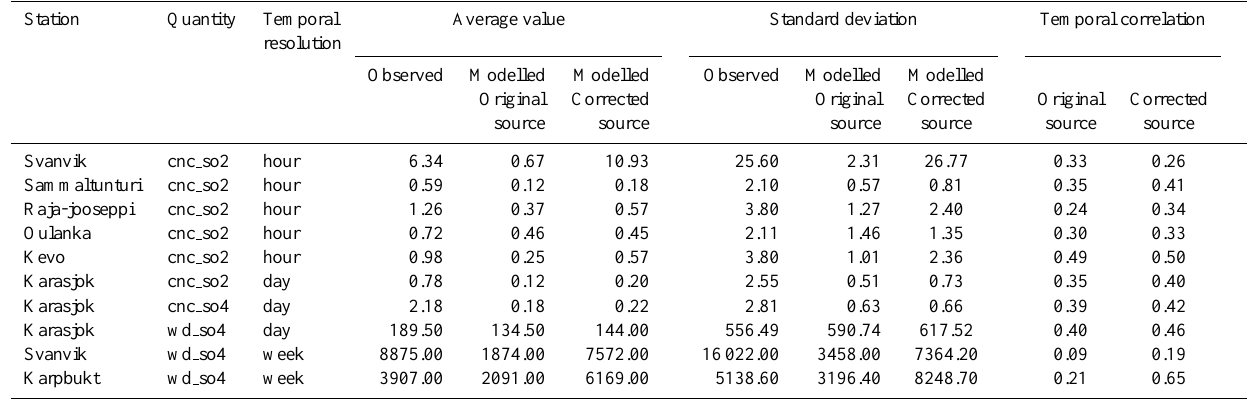
Table 5. Statistical scores of SILAM two-years computations at the monitoring sites. Mean over 2003 and 2006. Station Quantity Temporal Average value Standard